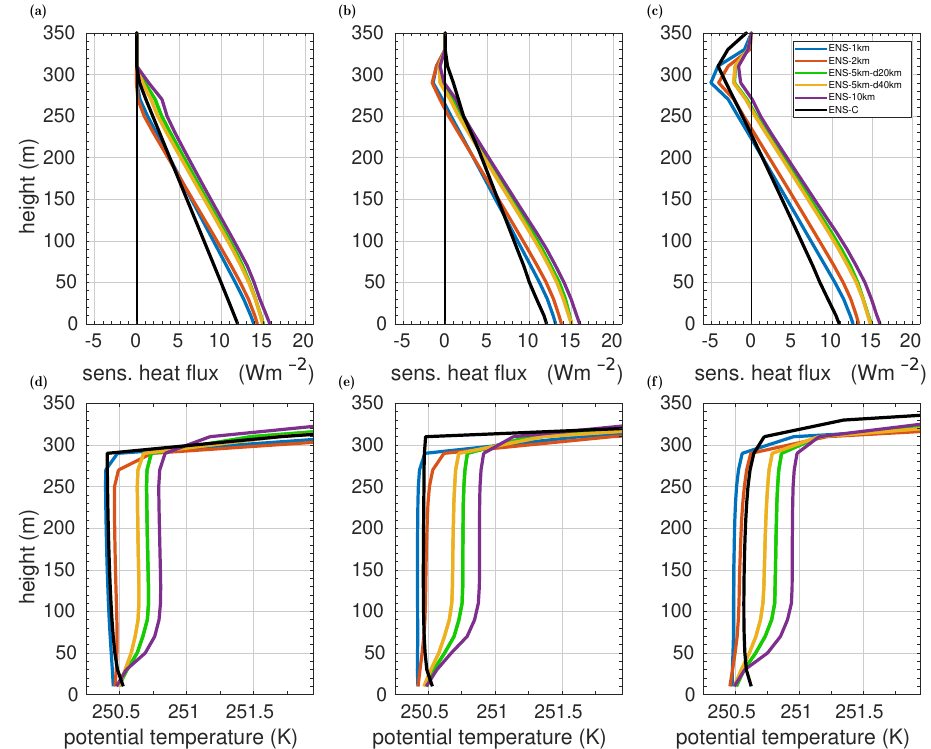
Figure 6. Vertical profiles veraged over a region of 105km length and with an average sea ice concentration of 91% obtained for the six different cases for sensible heat flux ( a – c ) and potential temperature ( d – f ). Model results are shown from the runs with the local closure for all lead scenarios ( a , d ), the non-local closures with fixed z i ( b , e ), and the non-local closures with variable z i ( c , f ). Cases and model runs are described in Figure 2 and Table 1 (see Section 2). The figure is a modified version of a similar one shown by Michaelis